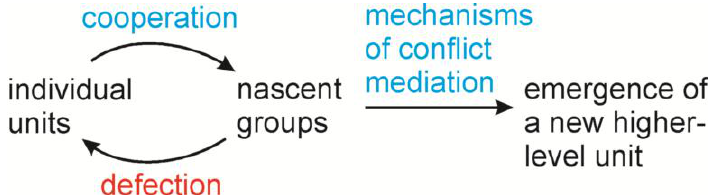
Figure 1. Cycles of cooperation and conflict occur repeatedly in the history of life with individual biological units banding together to form groups and defecting individuals weakening the integrity of groups. For a higher-level biological unit to form, mechanisms of conflict mediation must be derived [20].